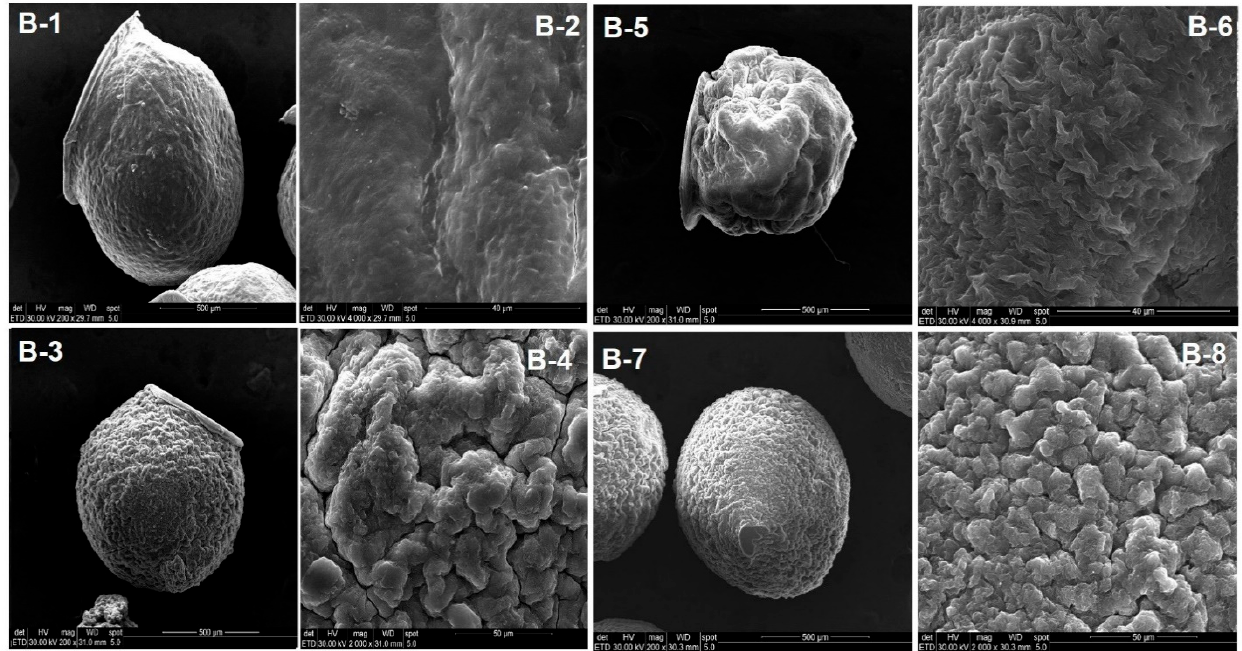
Figure 11. SEM images of the loaded ( B-1 – B-8 ) hydrogel beads. Figures B-1 and B-2 display loaded CS-TPP particles and their surface details. Layered loaded CS-TPP beads with kCG for 1 h, 3 h, and 6 h are illustrated in figures B-3 , B-5 , and B-7 , respectively, and their detailed surface textures are depicted in B-4 , B-6 and B-8 .